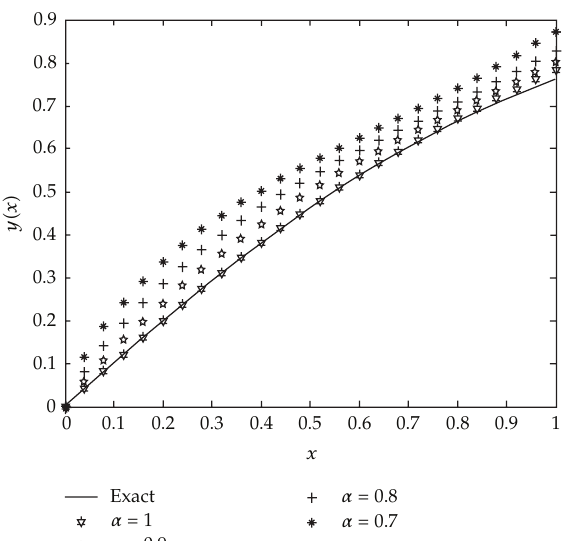
Figure 2: Plots of approx. solution y 3 (cid:3) x (cid:4) for di ff erent values of α .